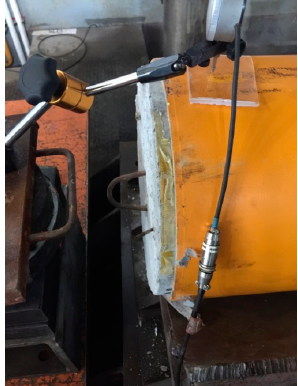
Figure 6. Slip between GFRP tube and concrete.